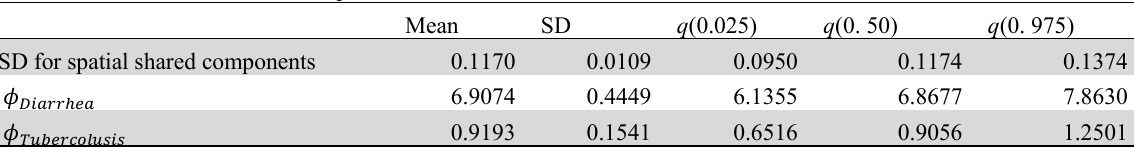
Fig. 5. Smoothed related risk distribution in space and time